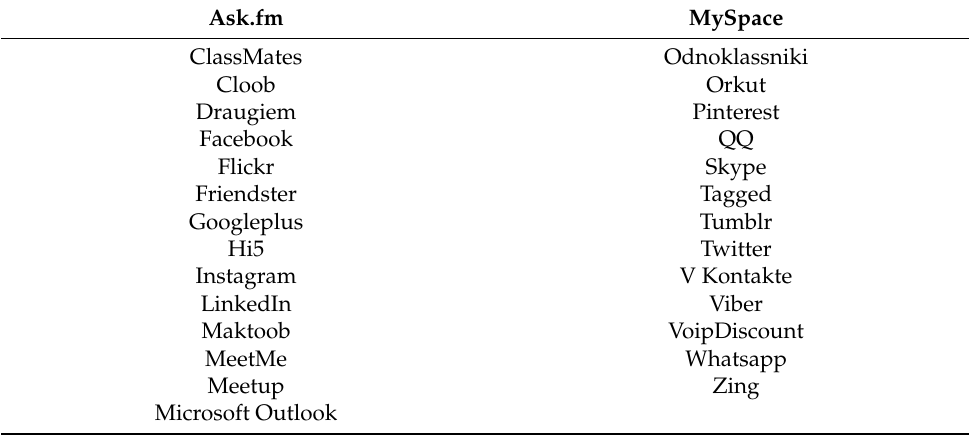
Table A3. This table lists the social media platforms considered when creating the social media popularity indicator variable, SocialMedia